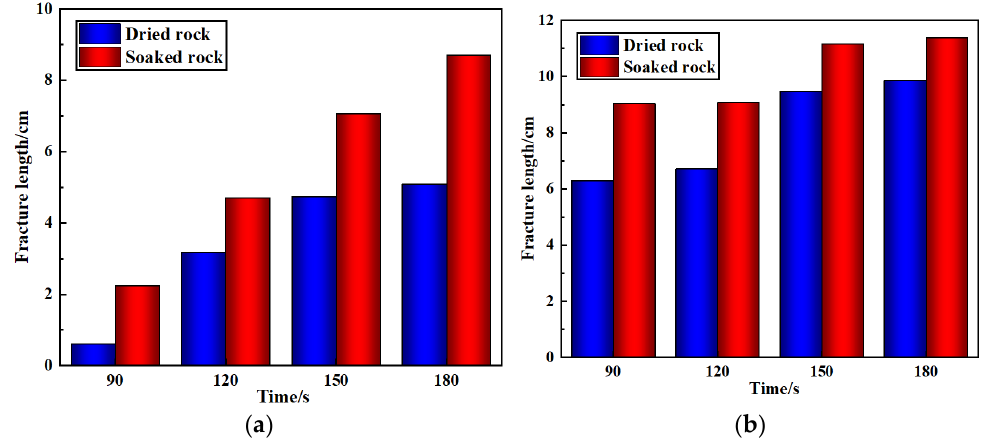
Figure 13. Fracture lengths of dried sample and soaked sample at different laser powers: ( a ) 90 W; and ( b ) 135 W.